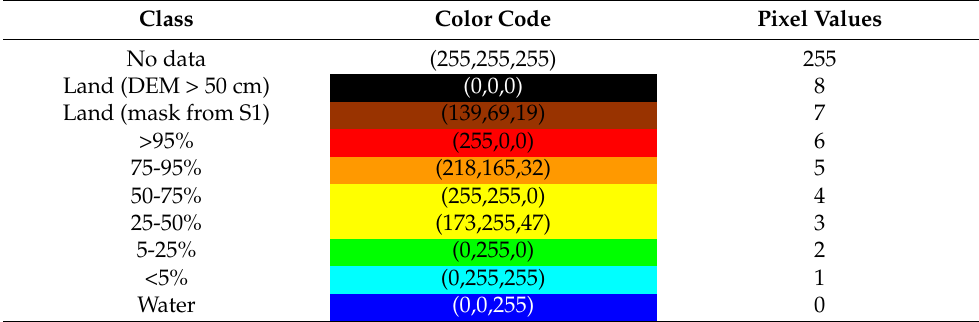
Table 3. Legend of intertidal zone atmospheric exposure